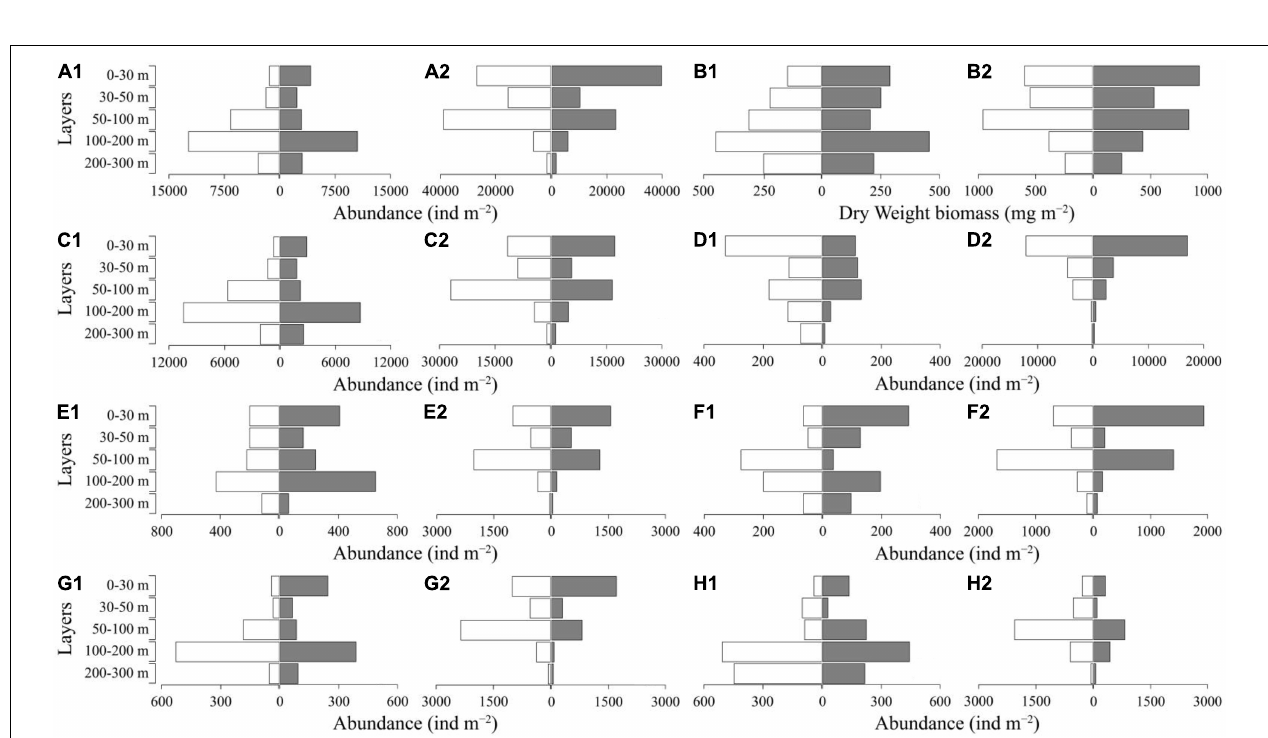
FIGURE 4 | Diel vertical distribution of mesozooplankton abundance and dry weight biomass in two fixed stations [ (A) total abundance; (B) total dry weight biomass; (C) copepod; (D) protozoan; (E) tunicate; (F) chaetognath; (G) pelagic larvae; (H) others; 1, station A; 2, station B; white, day; gray, night].